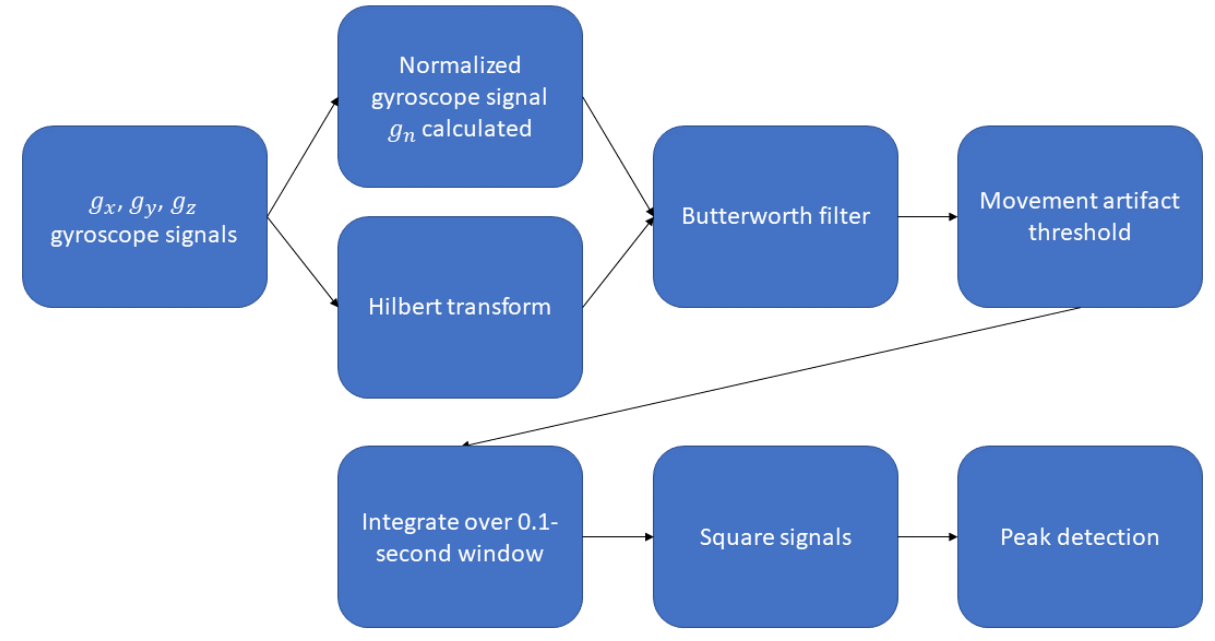
Figure 3. A summary of the proposed method for transforming the gyroscope signal to enable heartbeat